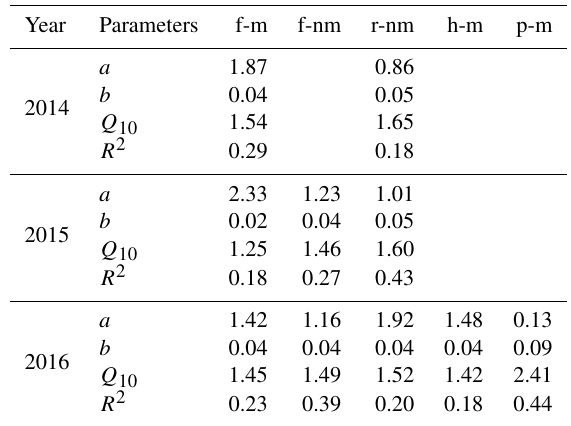
Table 2. Parameters for the fitted exponential equations relating soil respiration and soil temperature for different locations in the mulched and non-mulched fields (refer to Eqs. 4 and